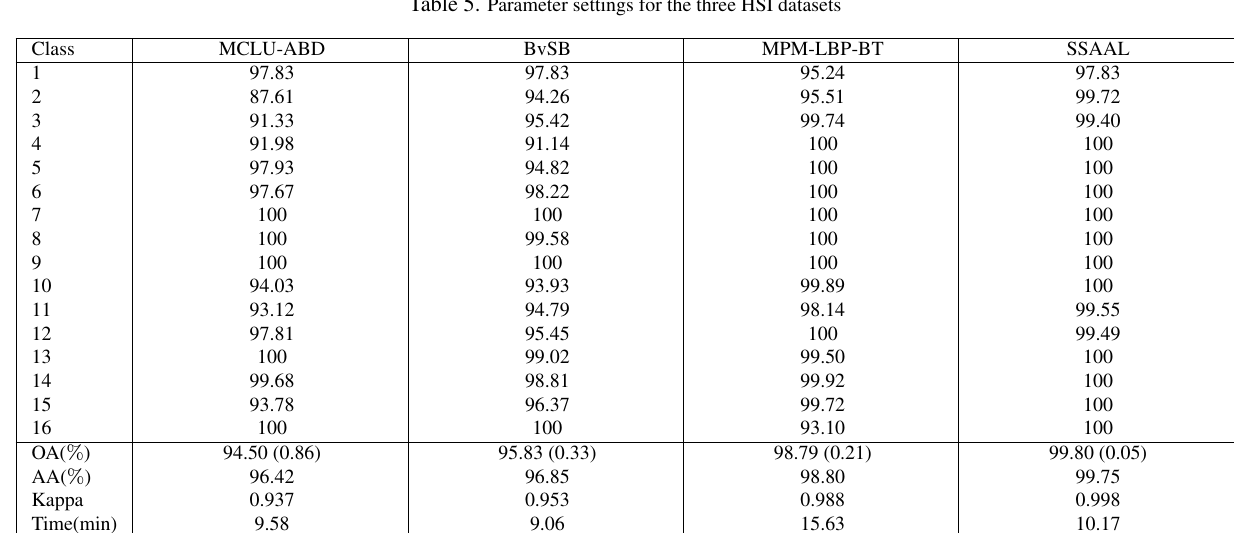
Table 6. Classification accuracies and computation time obtained by different AL techniques on Indian Pines dataset.